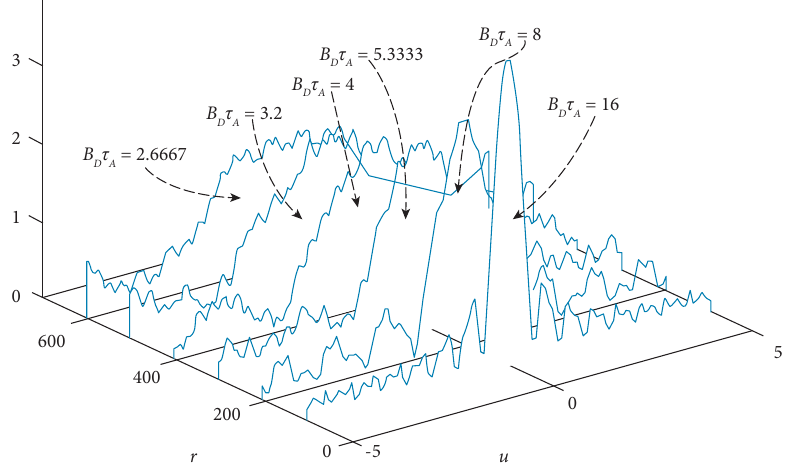
For targets at the NR, the Doppler bandwidth ( B